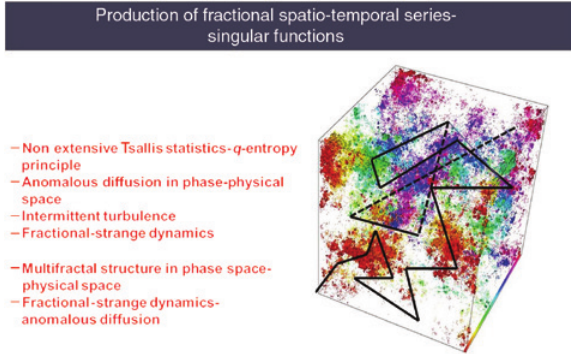
space it produce multifractal and singular time series. The phase space is structured as a multifractal set of dynamical microscopical states as the dynamics aims at the Tsallis q -entropy maximaization. order to show the different regions of phase space corresponding to